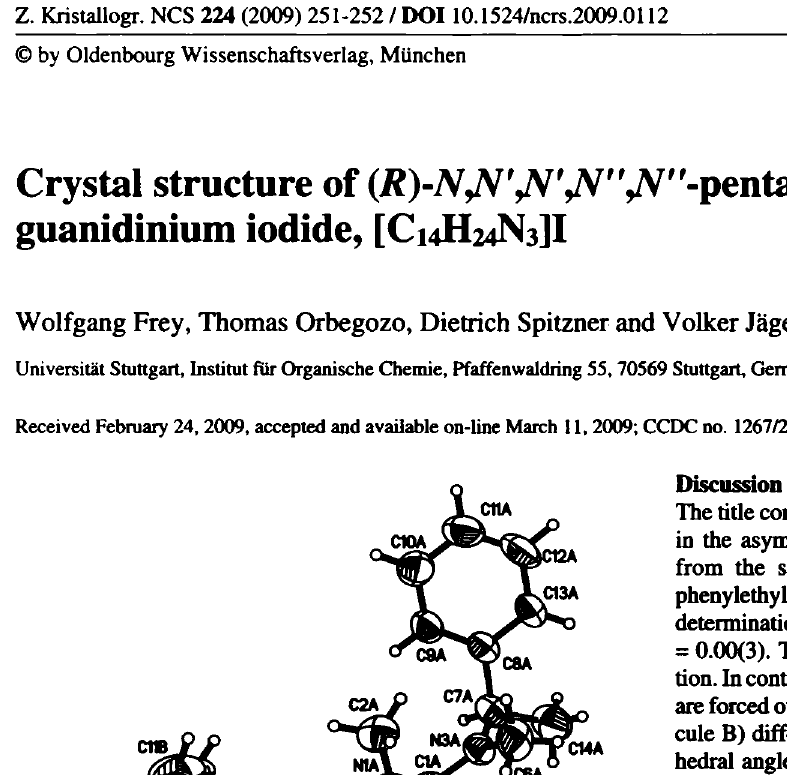
Table 1. Data collection and handling.